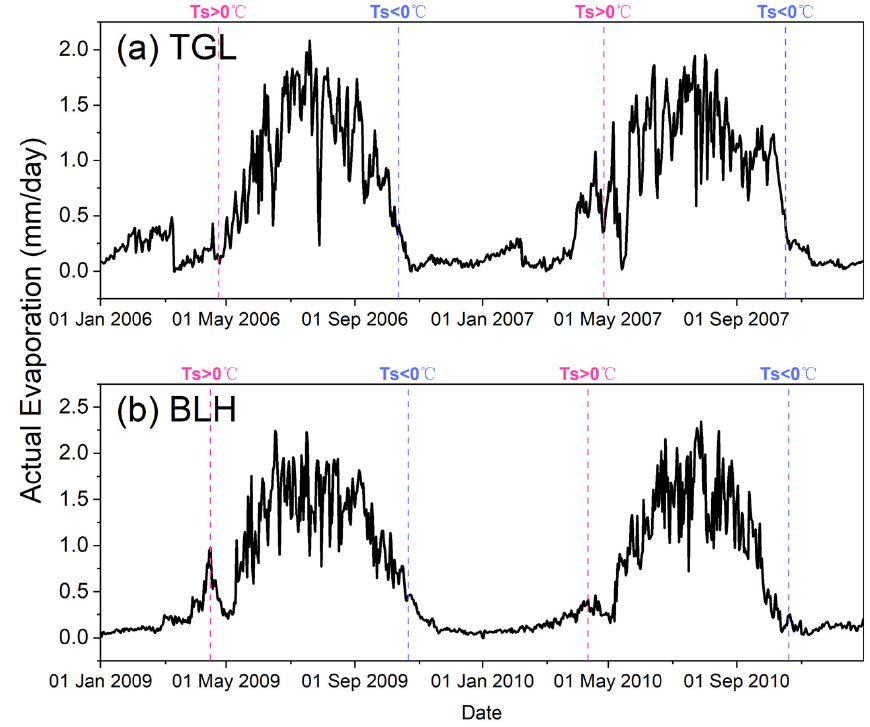
Figure 9. Seasonal variations in daily diurnal